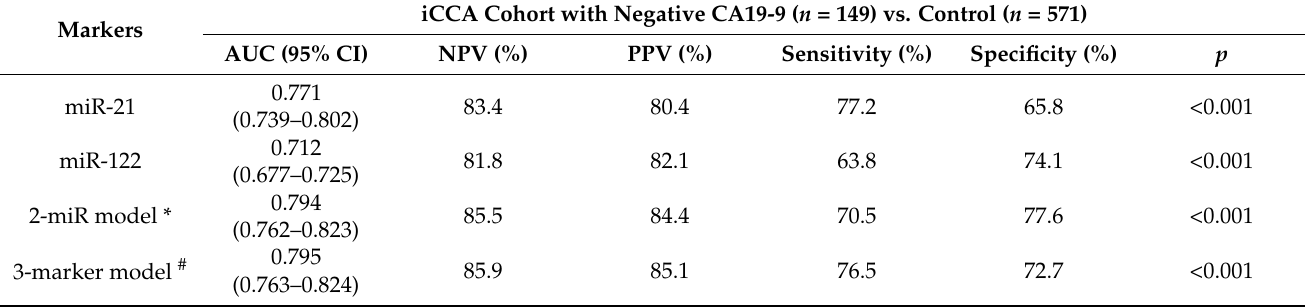
Table 4. Diagnostic performance of circulating markers for iCCA patients with negative CA19-9.